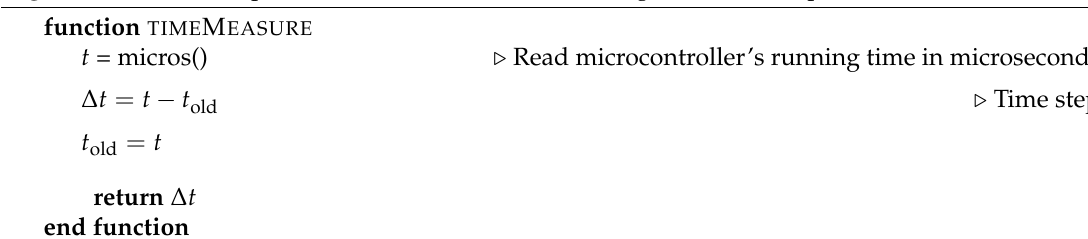
Algorithm 2 Model implementation in Arduino Due: Integration time